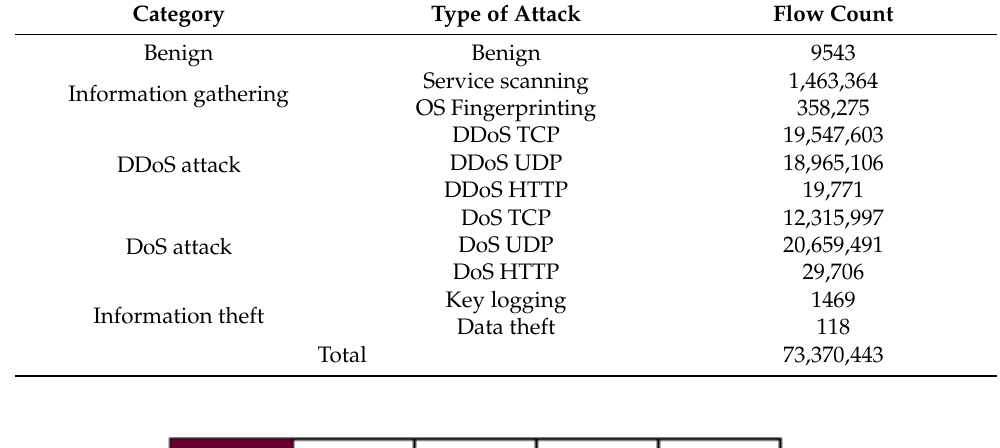
Table 2. BoT-IoT dataset.